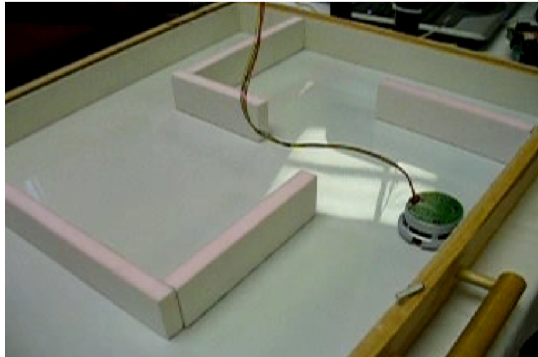
Figure 7. Robot Maze